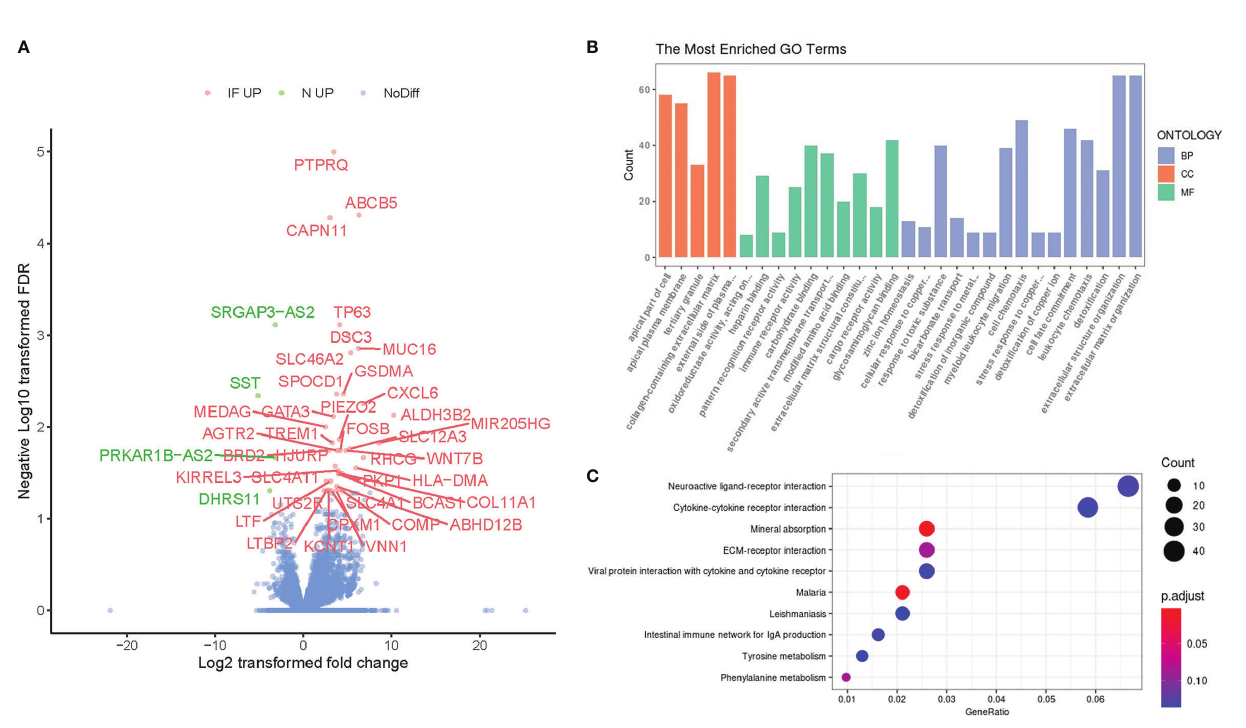
FIGURE 2 | Identi fi cation of differentially expressed genes (DEGs) and their functional enrichment analysis. (A) The volcano plot of DEGs between chronic epididymitis (CE) and the controls with the most signi fi cant DEGs labeled and highlighted (IF UP, upregulated in CE; NC UP, upregulated in the controls; NoDiff, no signi fi cant difference). (B) The most enriched GO terms for the DEGs. The horizontal axis represented different GO categories: the top 15 biological processes (BP), top 5 cellular components (CC), and top 10 molecular functions (MF). P < 0.05 & False discovery rate (FDR) < 0.05. (C) The top enriched KEGG pathways for the DEGs. The horizontal axis indicated the gene ratio which was de fi ned as the number of DEGs associated with particular term divided by the total number of the DEGs. P <